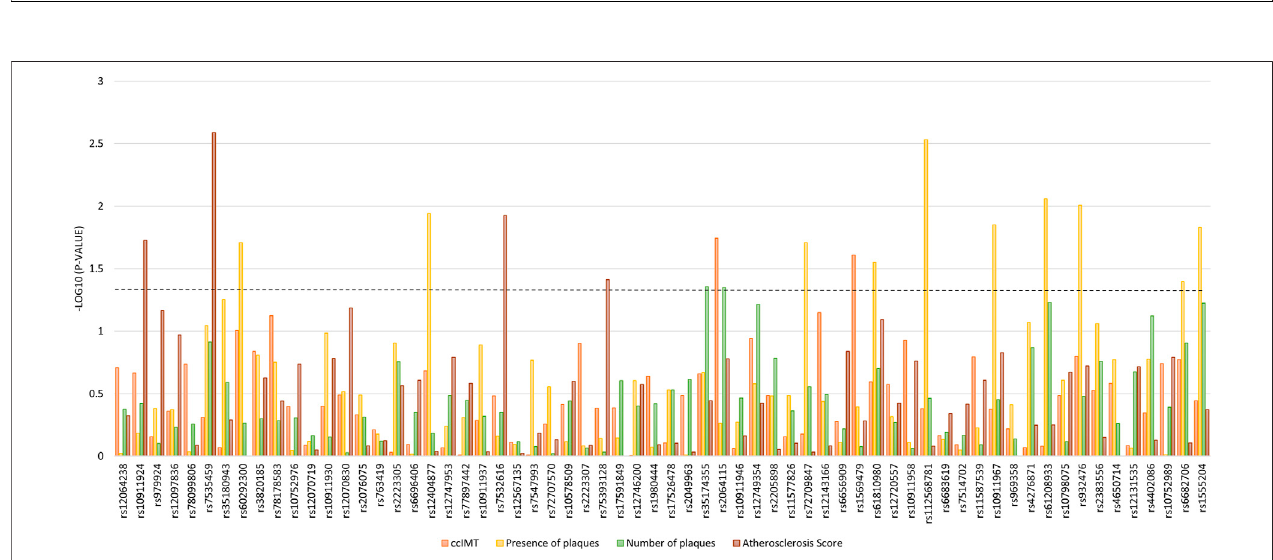
FIGURE 2 | Association between tag-SNPs in the PLA2G4A gene with atherosclerosis-related measurements. The dotted line denotes the level of statistical signi fi cance.